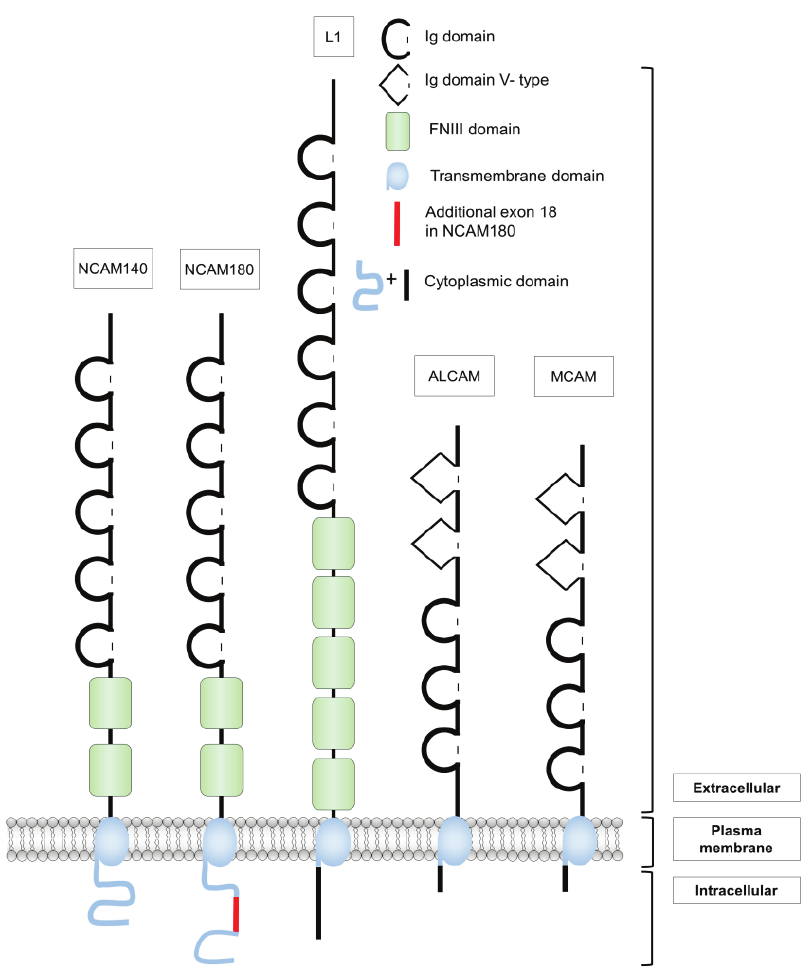
Figure 1. Overview about Immunoglobulin (Ig) superfamily members that are modified by ubiquitin. Ig superfamily members contain in their amino terminal extracellular domain Ig-like domains. Additionally, some of them have fibronectin (FN) type III domains (NCAM and L1). The ubiquitinated Ig superfamily members contain a transmembrane region and a cytoplasmic domain. NCAM: neural cell adhesion molecule; ALCAM: activated leukocyte cell adhesion molecule; MCAM: melanoma cell adhesion molecule; V: variable.